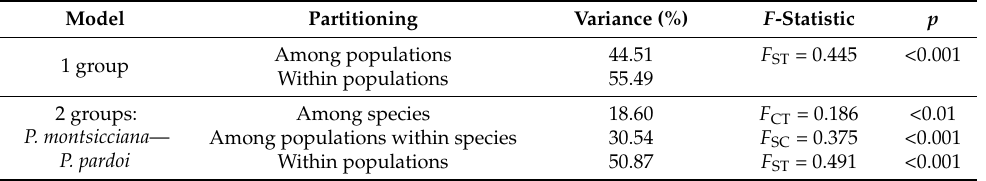
Figure 4. Principal Coordinate Analysis (PCoA) performed from pairwise genotypic distances between the studied populations of the pair Petrocoptis montsicciana / P. pardoi , at population ( A ) and at individual ( B ) level. Codes PM-CAM (red), PM-MCO (yellow), PM-MRB (blue) and PM-TER (green) are of populations of P. montsicciana , and codes PP-AGV (dark red), PP-BAR (light blue) and PP-CBD (pink) of P. pardoi (see Figure 1). Table 1. Analysis of molecular variance (AMOVA) in the pair Petrocoptis montsicciana / P. pardoi considering (1) all population together (one group) and (2) that the populations belong to different species (two groups).